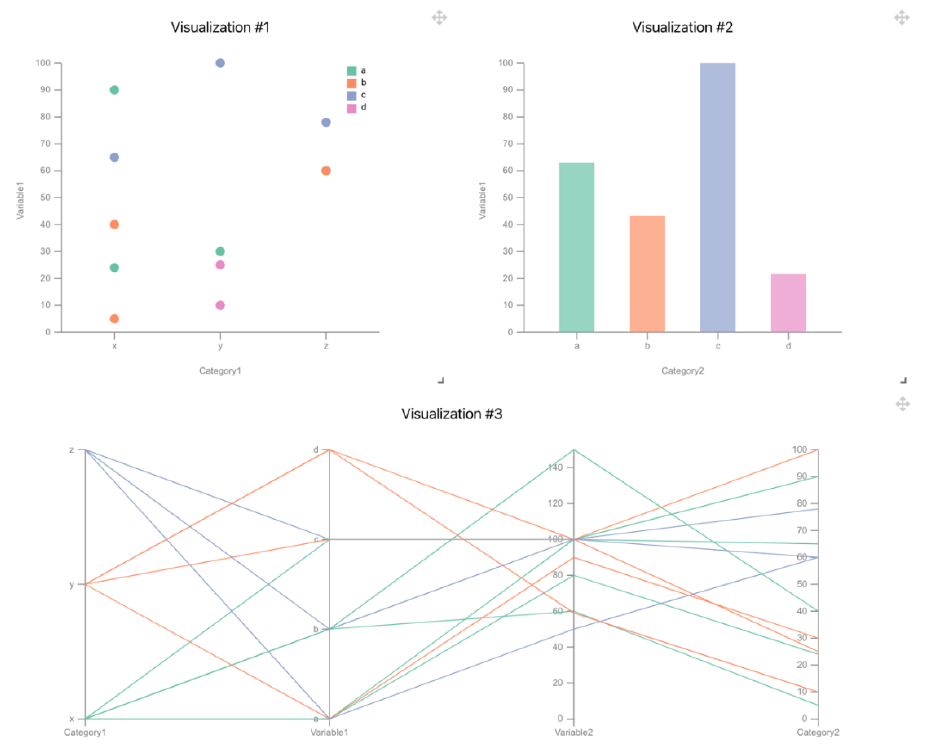
Figure 9. A sample dashboard generated by using the DSL.